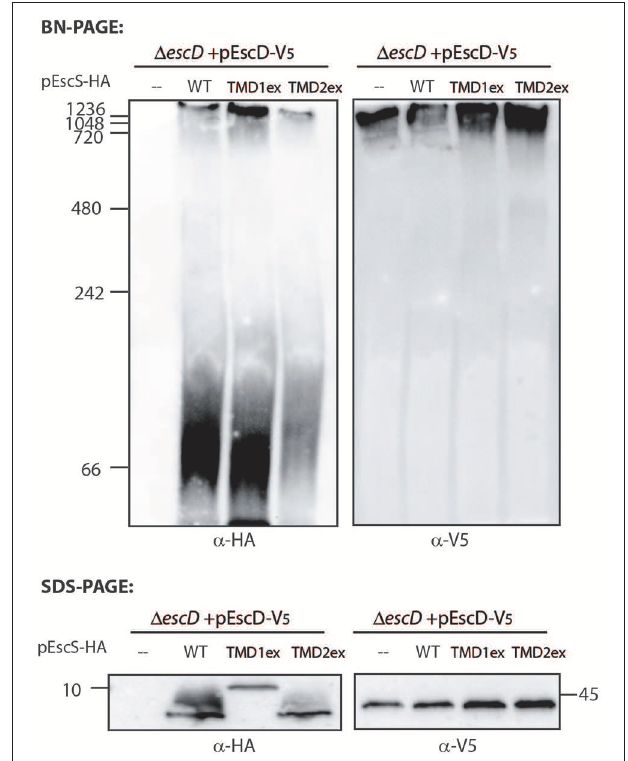
FIGURE 7 | TMD-exchanged versions of EscS associate with the T3SS complex. Membrane protein extracts of 1 escD carrying pEscD-V 5 alone or in combination with pEscS wt -HA, pEscS-TMD1 ex -HA, or pEscS-TMD2 ex -HA, were incubated in BN sample buffer and then subjected to BN-PAGE (upper panel), SDS-PAGE (lower panel) and western blot analysis using anti-V 5 and anti-HA antibodies. ( Upper panel ) BN-PAGE analysis showed that while the EscD-V 5 protein migrated mainly as a large complex at the top of the gel, the EscS WT and the exchanged TMD-versions migrated both as large and small protein complexes. ( Lower panel ) To confirm similar EscS and EscD expression among the samples, membrane protein extracts were analyzed by SDS-PAGE and western blot analysis using anti-HA and anti-V 5 antibodies. Similar protein expression levels were